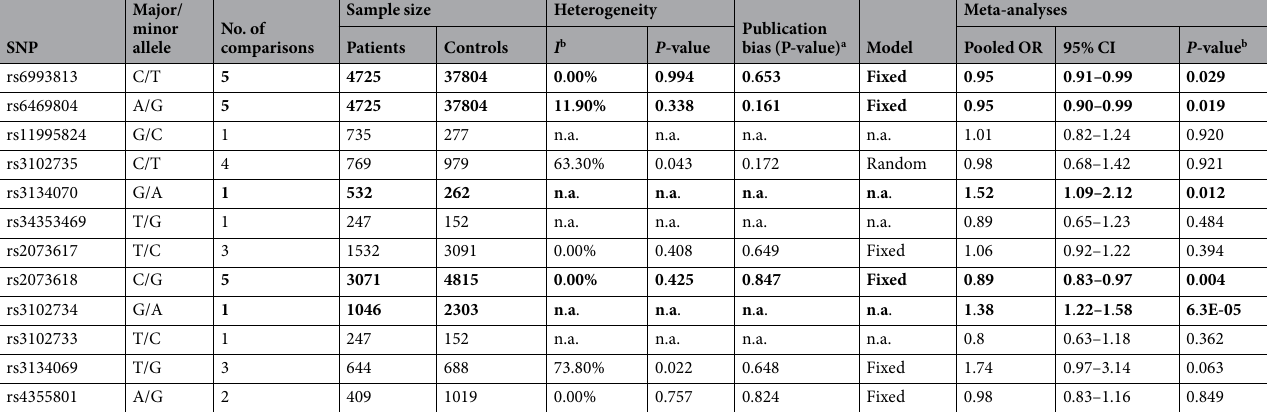
Table 4. Statistics of meta-analyses for all included OPG SNPs. a Results of Egger test; b P -value of significance was set at 0.004 by using the Bonferroni Correction. Supplementary materials included Tables S1–S3, PRISMA checklist and PRISMA flow